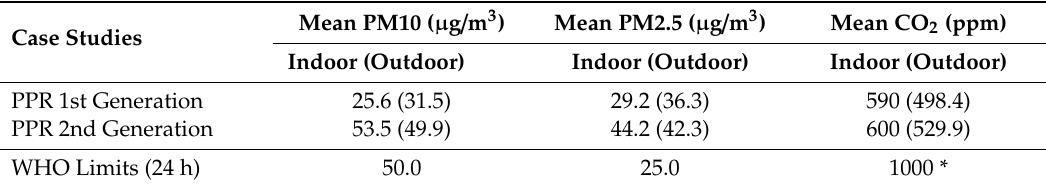
Table 5. Findings of the second fieldwork study.